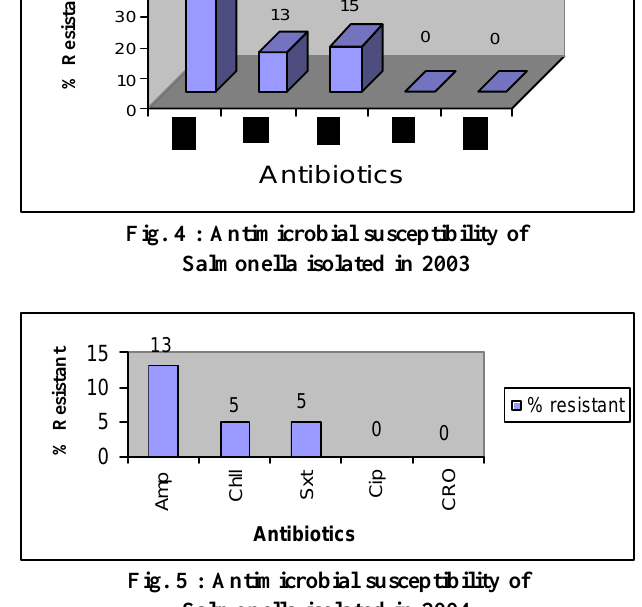
n t a s t s i R e %